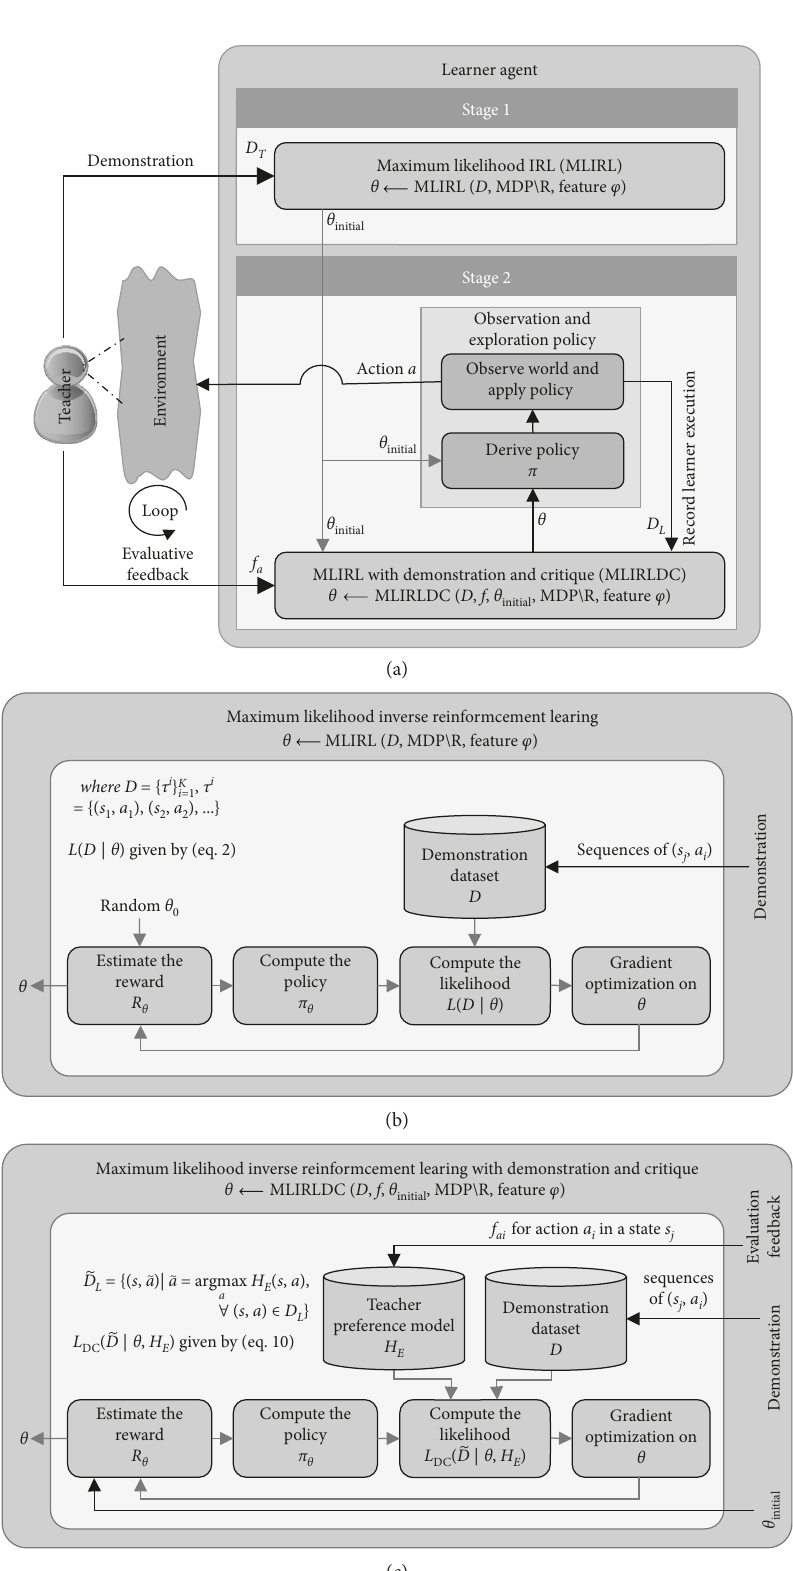
Figure 1: (a) Schematic overview of the IRLDC framework. (b)MLIRL block diagram with only demonstration input. (c) Our MLIRLDC block diagram with demonstration and feedback